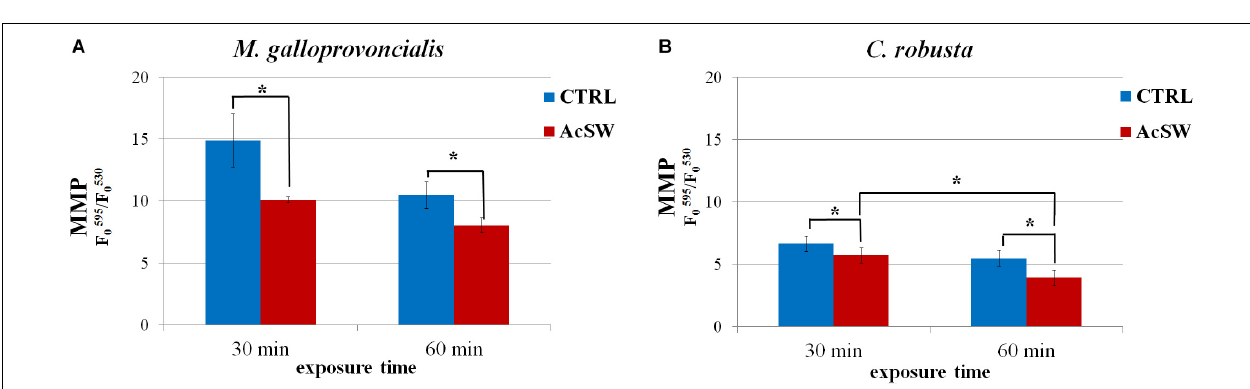
FIGURE 2 | Effects of acidified seawater (AcSW) on mitochondrial membrane potential (MMP) in M. galloprovincialis (A) and C. robusta (B) spermatozoa (mean ± SE). MMP value was calculated as red ( ∼ 595 nm) to green ( ∼ 535 nm) fluorescence emission peak ratio in spermatozoa exposed for 30 and 60 min to filtered natural seawater with a natural pH value of 8.1 (CTRL) and to AcSW with a pH value of 7.8. ∗ indicates statistically significant differences ( P ≤